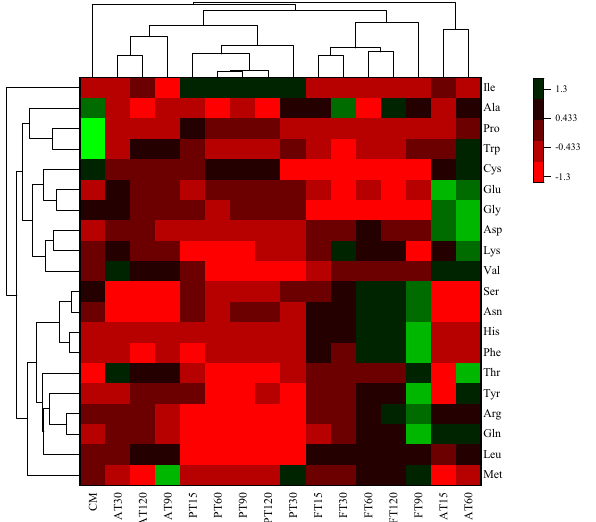
MetLeuGlnArgTyrThrPheHisAsnSerValLysAspGlyGluCysTrpProAlaIle Figure 9. Hierarchical clustering of free amino acids in CM, AT, PT and FT ( P < 0.05). The bar color represents a logarithmic scale from − 1.3 to 1.3. Alcalase-treated cow milk (AT), Protamex-treated cow milk (PT), Flavourzyme-treated cow milk (FT). Each column indicates a sample, and each row indicates a free amino